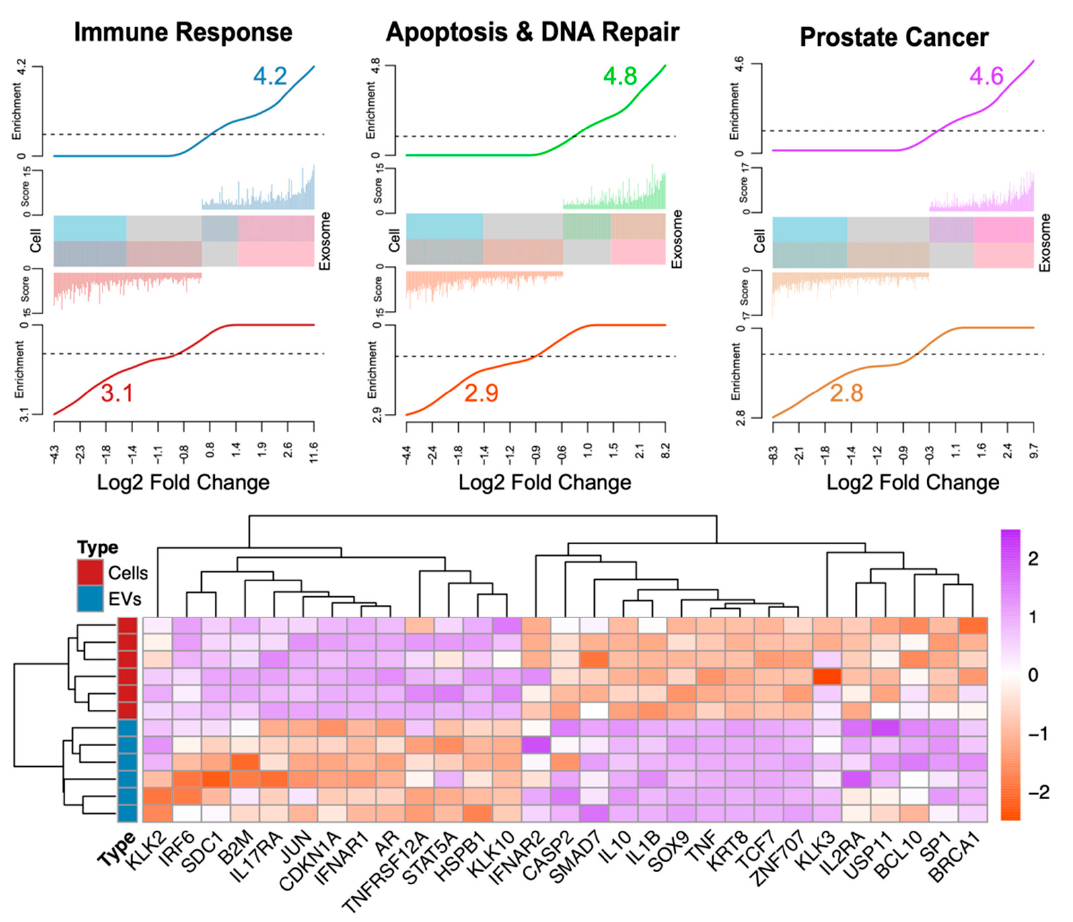
Figure 2. Barcode plot figure [68] showing significantly higher enrichments in exosomes compared to cells associated with immune response (n = 236 transcripts), apoptosis and DNA repair (n = 200), and prostate cancer (n = 262). The barcode plot shows the log2 fold change in the X-axis. The Y-axis is composed by score (-log10 false discovery rate or adjusted p values) and enrichment (gene set-weighted density estimation). The middle bar and colored histogram in either top or bottom of the bar reflect the number of differentially expressed genes (adjusted p values < 0.05). The bottom section of the figure shows the standardized expression profiles of genes associated to the pathways showed in the top section. The data in this figure are available through Dogra et al. [37], representing the comparison between patient tissues and serum-extracted exosomes. CTCs are cells that are released into circulation from a tumor or site of